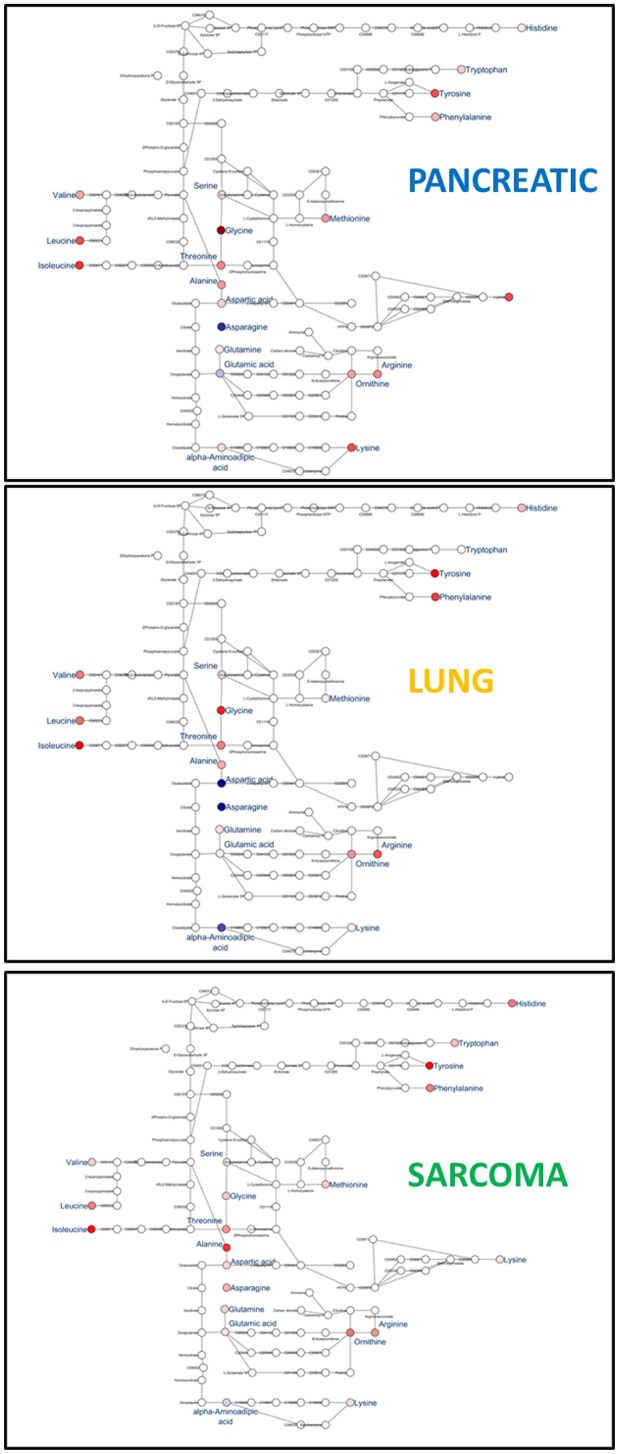
Schematic representation of KEGG Biosynthesis of amino acids pathway in the brains of pancreatic cancer-, lung cancer-, and sarcoma- bearing mice, as compared to controls. Red denotes upregulation as compared to controls; blue denotes downregulation to as compared to controls (see Table 1 for numeric values).